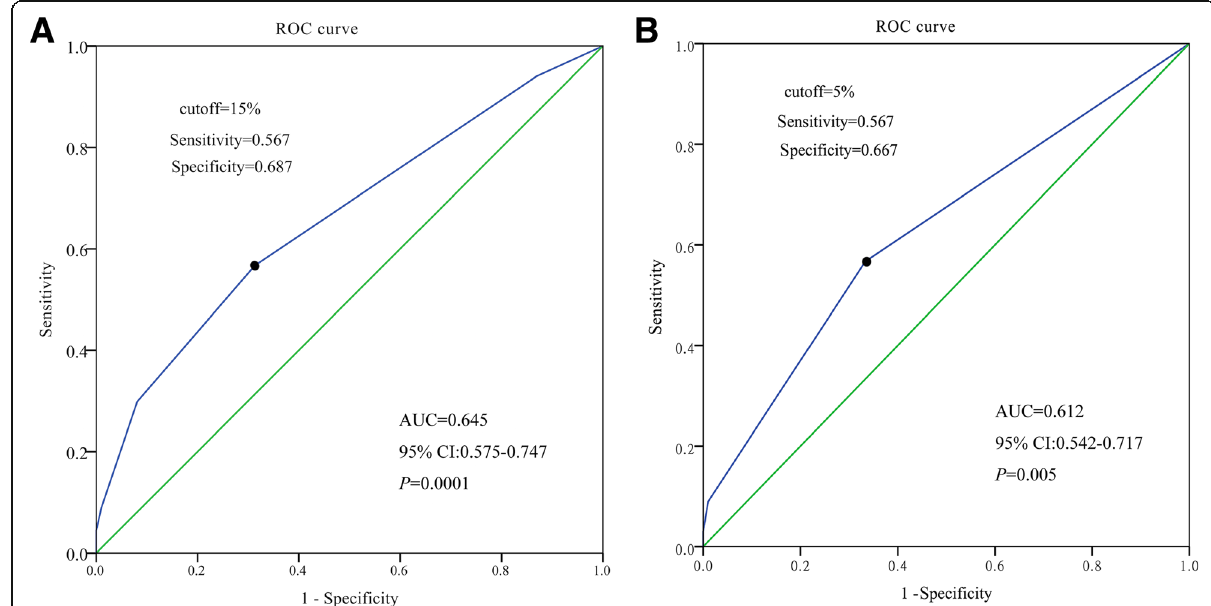
Fig. 3 Receiver operating characteristics (ROC) analysis for the thresholds of TILs to predict pCR in neoadjuvant treated TNBCs. ROC curves of sTILs (a) and iTILs (b) . The black dot indicated the optimal threshold. The area under the curve (AUC), 95% confidence interval (CI) and P -value were listed in the picture